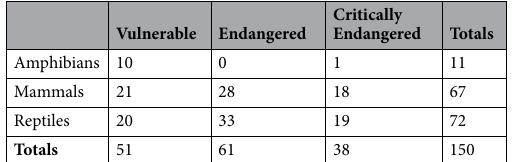
Table 1. Vulnerable, endangered and critically endangered species found in the study